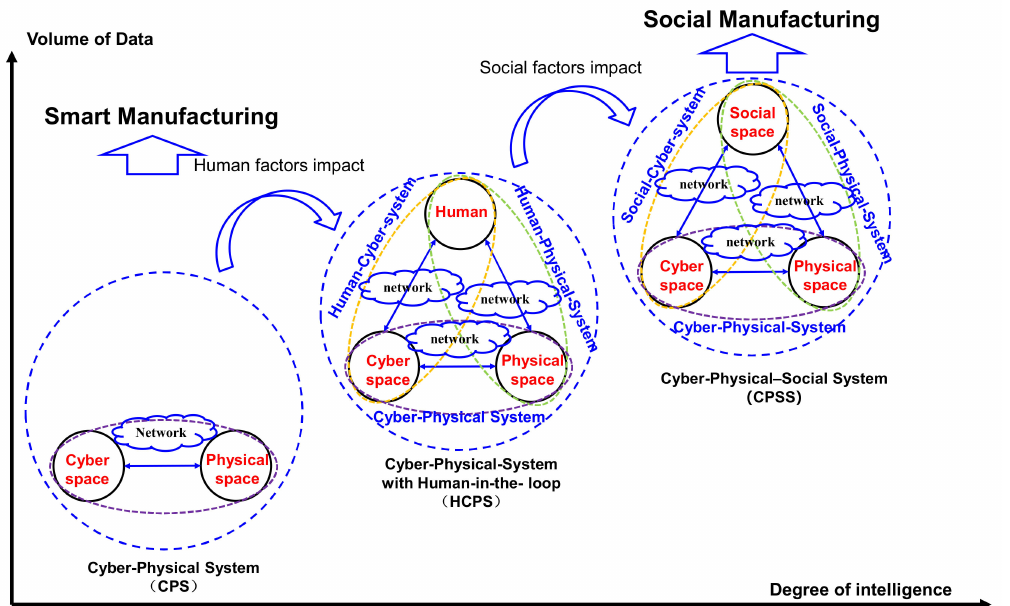
Figure 1. Evolution of the cyber–physical–social system